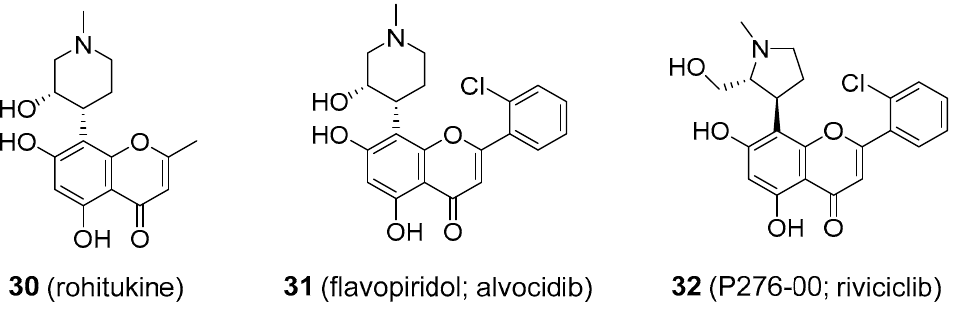
Figure 7. Natural rohitukine and some of its synthetic derivatives with anticancer properties.